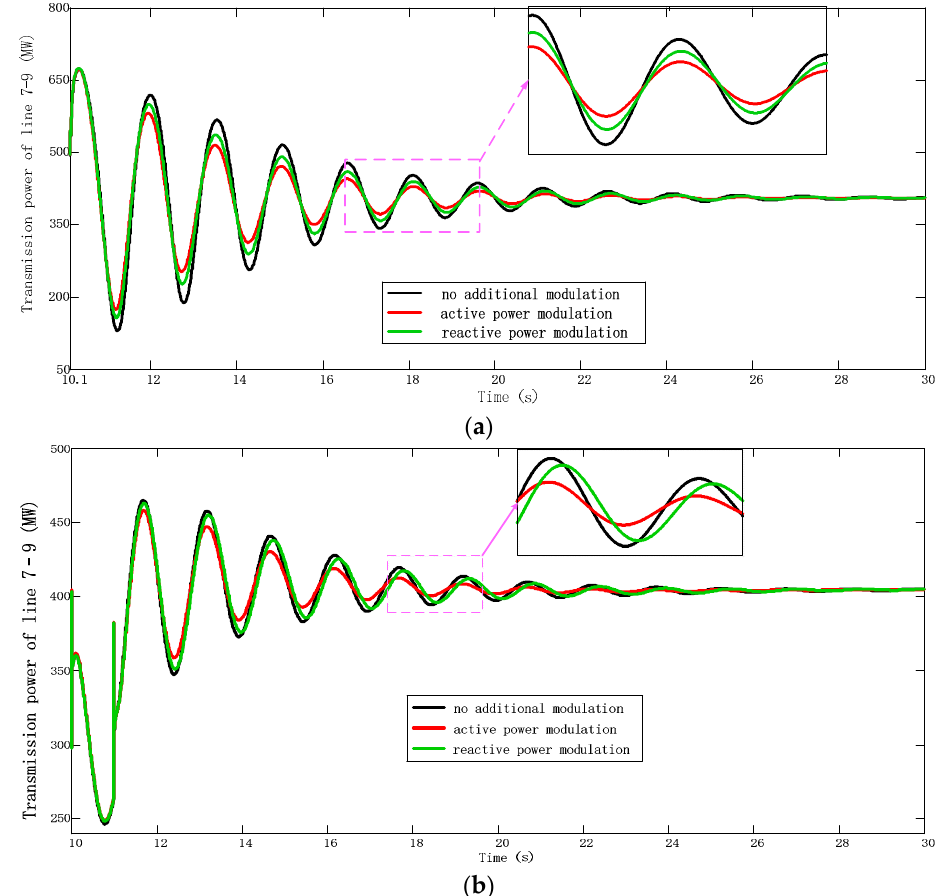
Figure 6. ( a ) Transmission power of Line 7–9 at Case A; ( b ) Transmission power of Line 7–9 at Case B.